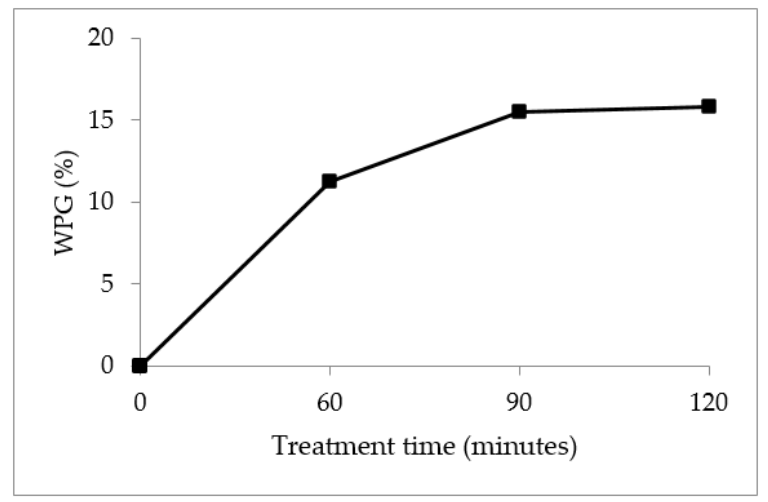
Figure 4. WPG of MA-treated KBF at different treatment times.